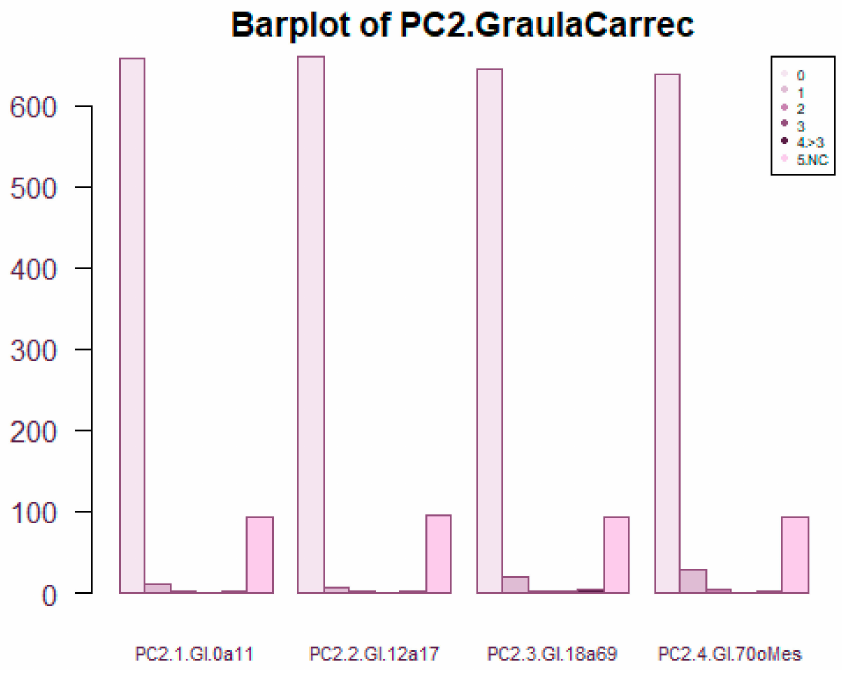
Figure 28. Multiple bar plot or degree I dependent people in charge per age group. See Cross table of question PC2 with the number of degree I dependent people in charge per age group Figure 29, temporal proportions table in Figure 30 grid of pie charts in Figure